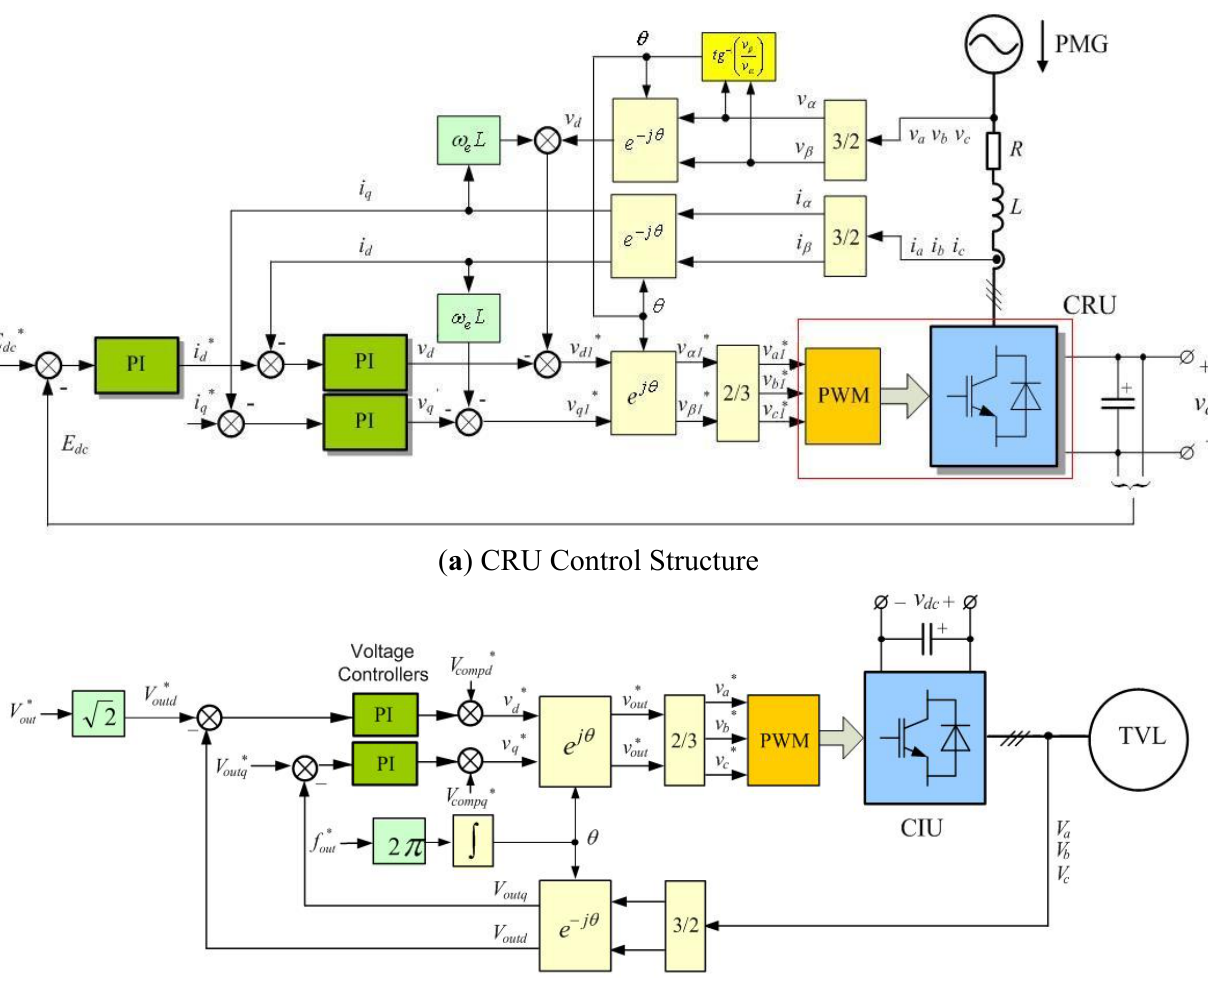
Figure 2. Converter control topologies: ( a ) CRU Control Structure; ( b ) CIU Control